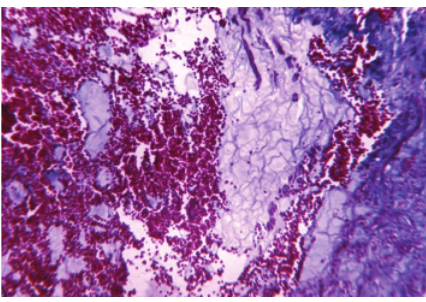
Figure 8: Pancreatic ducts resistant to necrotic changes (A). Des- quamation of ductal epithelium (B). H&E ( ×